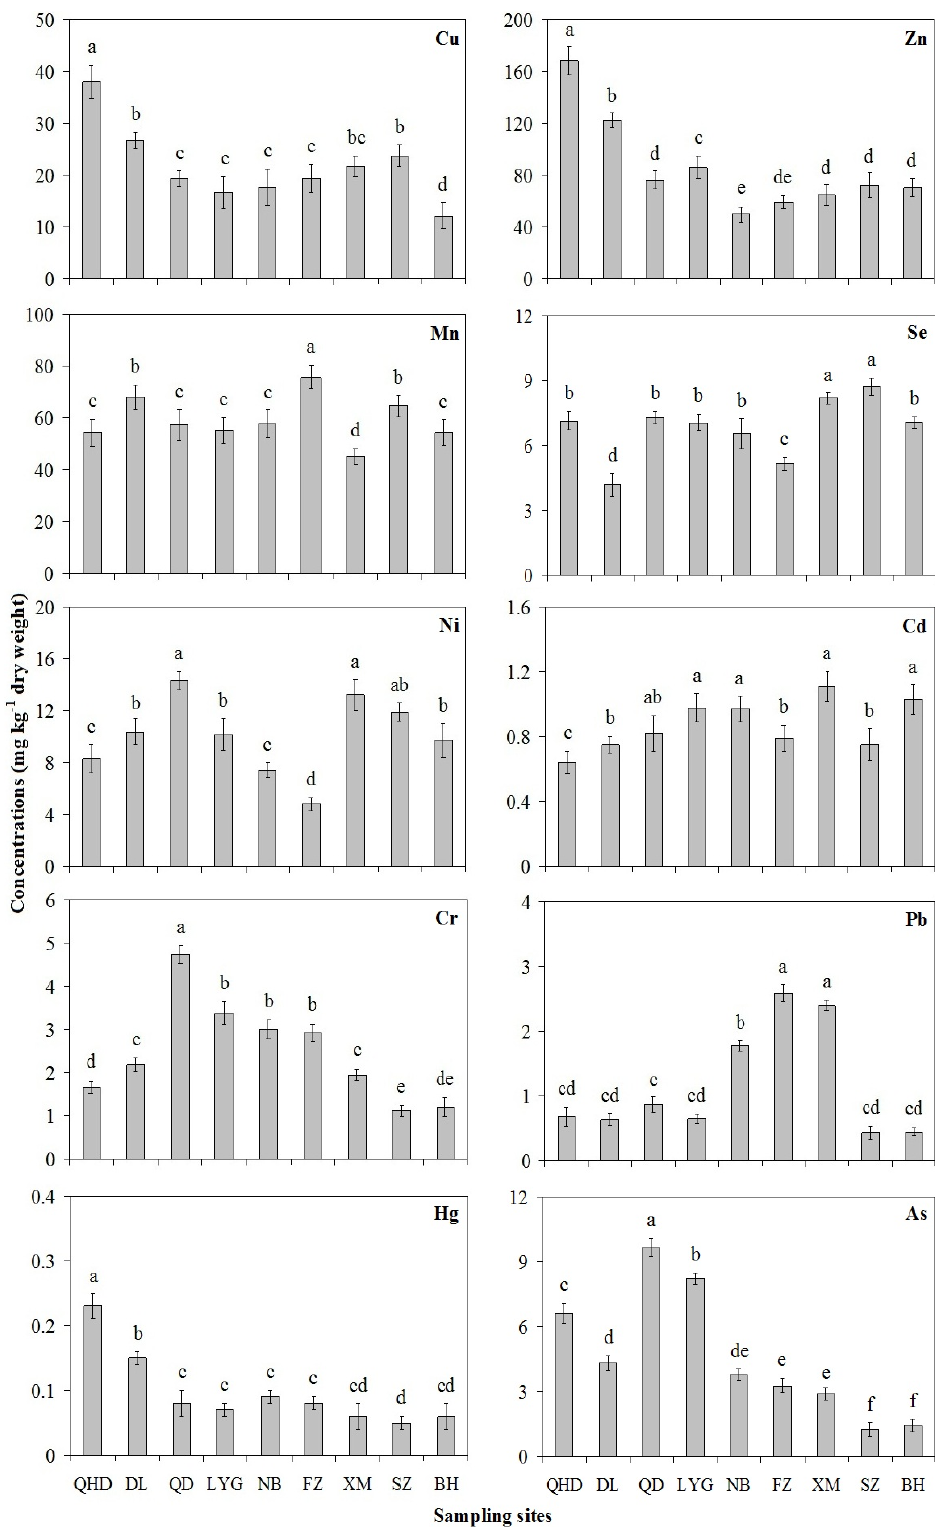
Figure 2. Trace element concentrations (mg·kg −1 dry weight) in Ruditapes philippinarum along the coast of China. Values with different marks represent significant difference at the significance level of 0.05. Data are expressed as mean ±SD (n = 3). QHD: Qinghuangdao; DL: Dalian; QD: Qingdao; LYG: Lianyungang; NB: Ningbo; FZ: Fuzhou; XM: Xiamen; SZ: Shenzheng; BH: